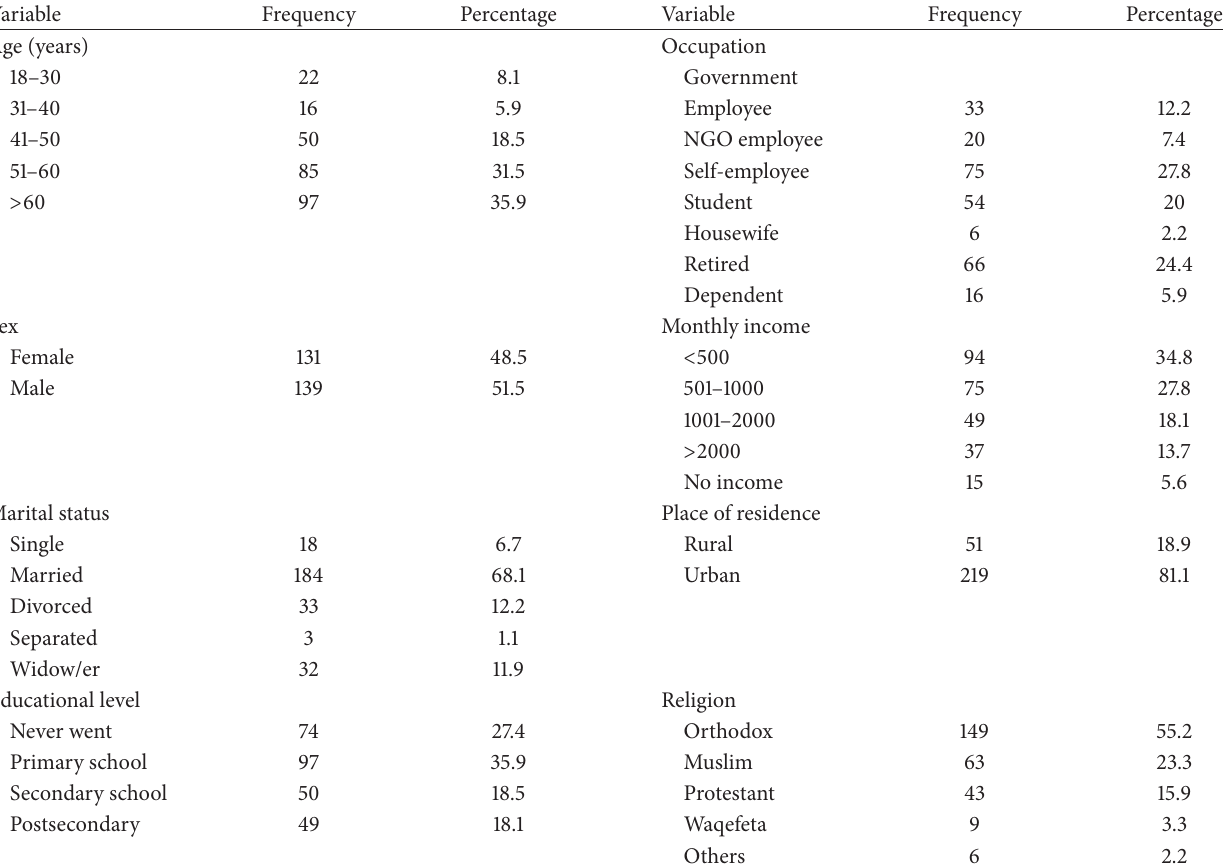
Table 1: Sociodemographic characteristics of patients, Adama, Ethiopia, 2014.